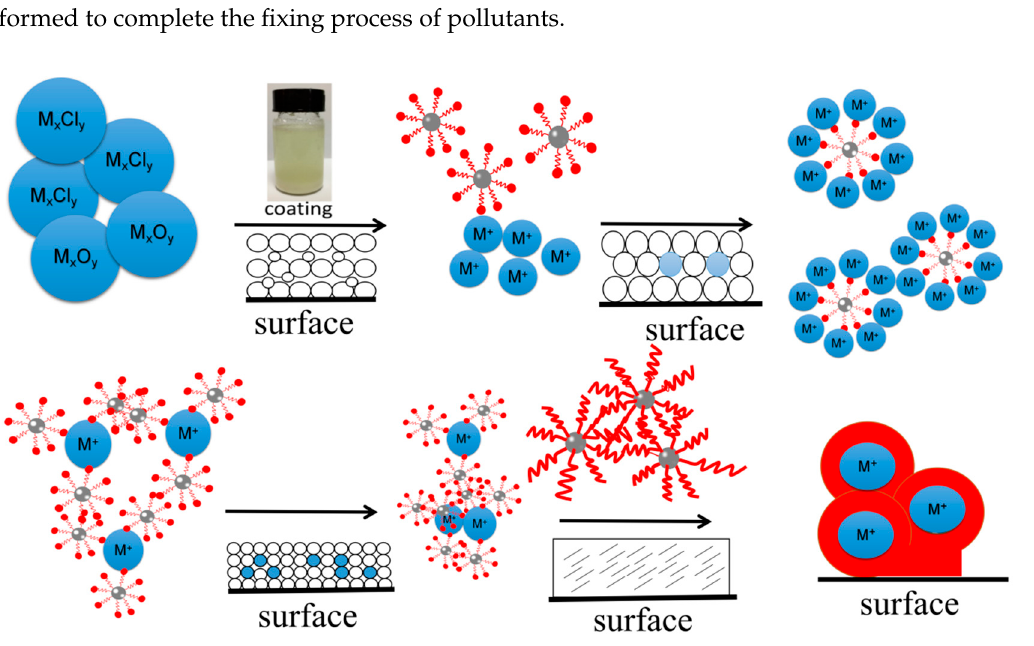
Figure 7. The activity of decontaminant on insoluble nuclide compounds.